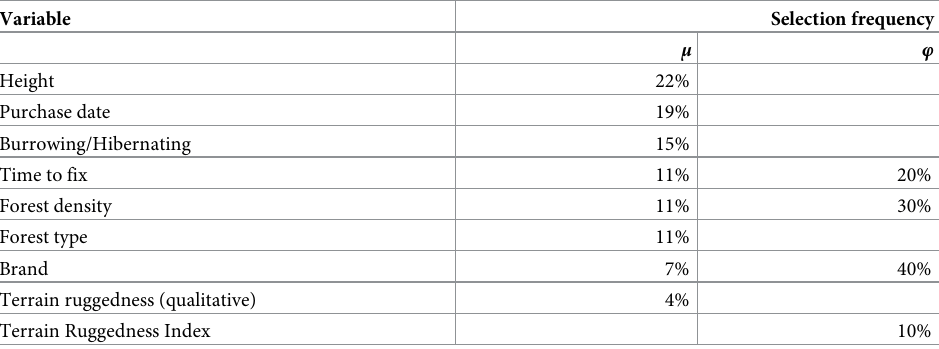
Table 2. Selection frequencies of covariates for both the mean ( μ ) and variability ( φ ) parameters in the boosted beta regression model for the fix acquisition rate. Variable Selection frequency μ φ Height 22% Purchase date 19% Burrowing/Hibernating 15% Time to fix 11% 20% Forest density 11% 30% Forest type 11% Brand 7% 40% Terrain ruggedness (qualitative) 4% Terrain Ruggedness